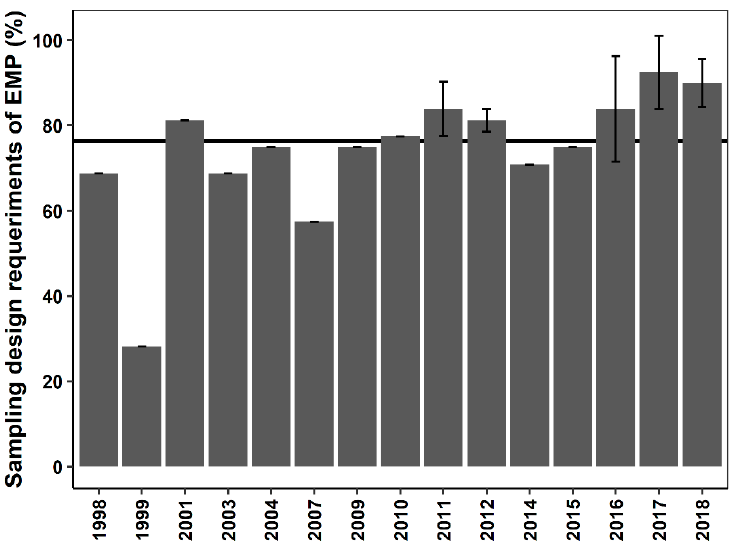
Figure 8. Mean values of sampling design requirements for each EMP assessed (bars represent standard deviation and solid black line indicates the general average).